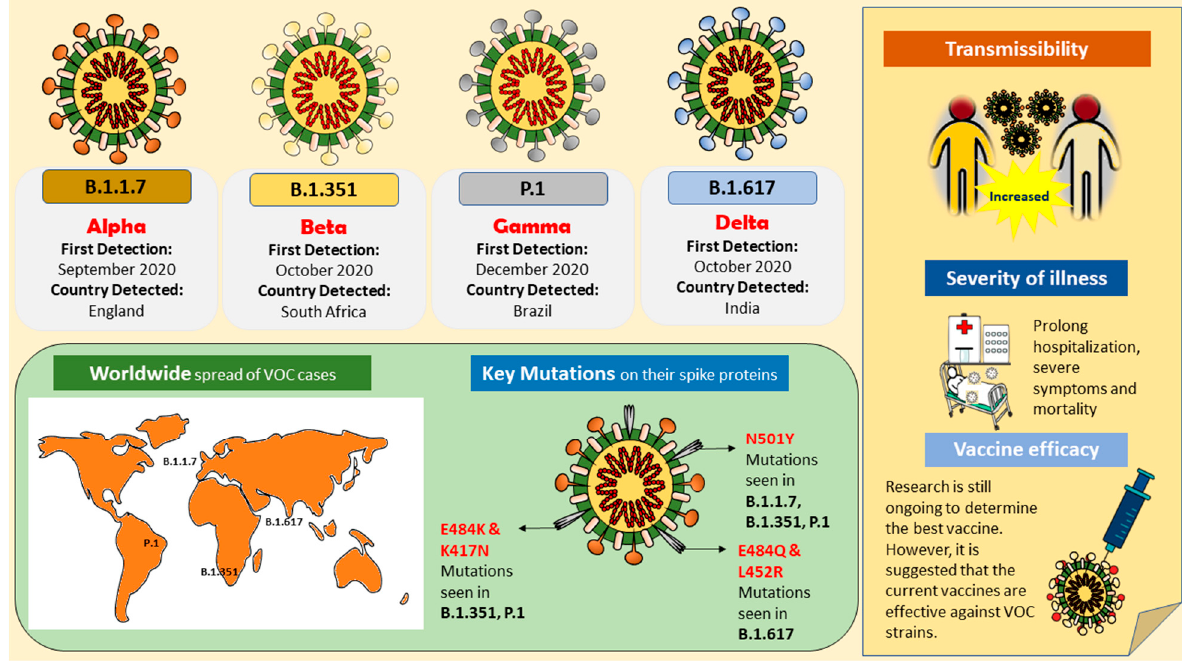
Figure 1. Illustration of variants of concern (VOCs); B.1.1.7 (Alpha), B.1.351 (Beta), B.1.617/B.1.617.2 (Delta), and P.1 (Gamma), their key mutations, and their impact on the public health.